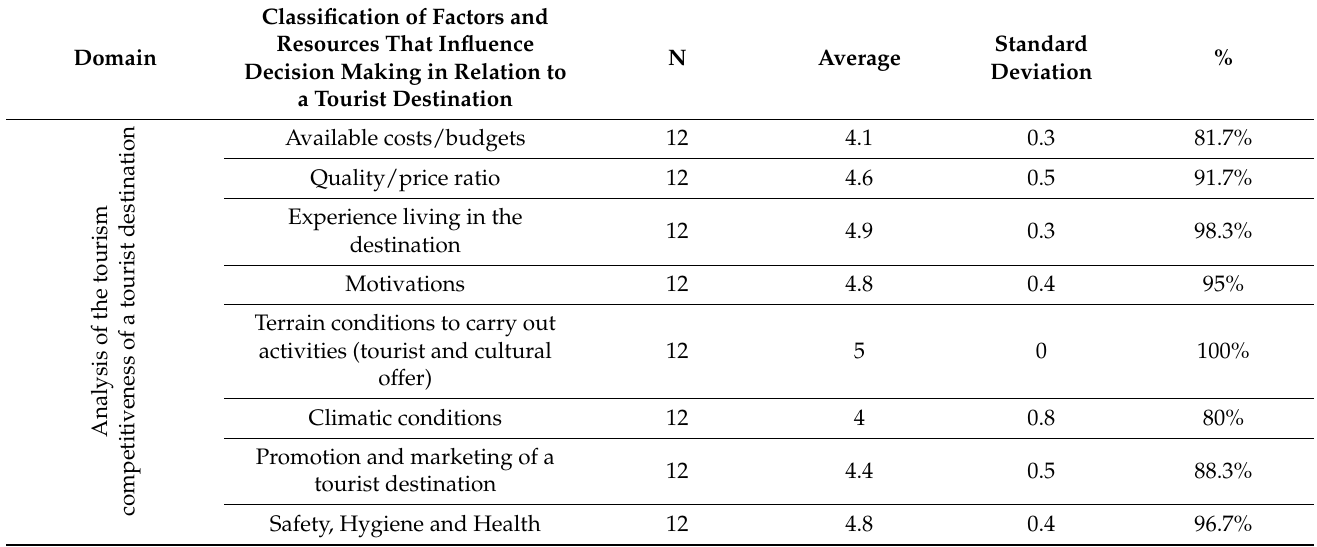
Table 12. Results of the second round of interviews-domain Analysis of the tourism competitiveness of a tourist destination. Source: Elaborated by the